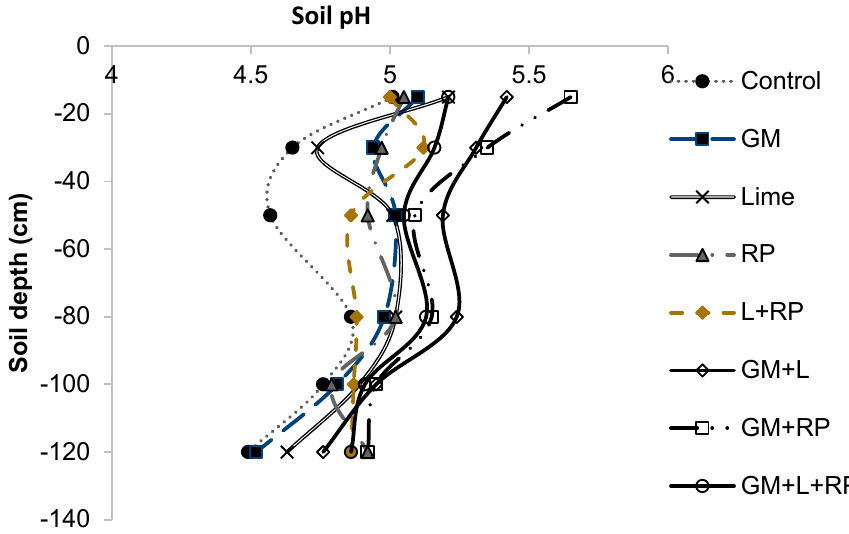
Figure 5. Increase in soil pH of acid sulphate soils by green manuring during pre- Kharif and application of soil amendments during the pre-Rabi season in the Ganges Delta. Source: [59].